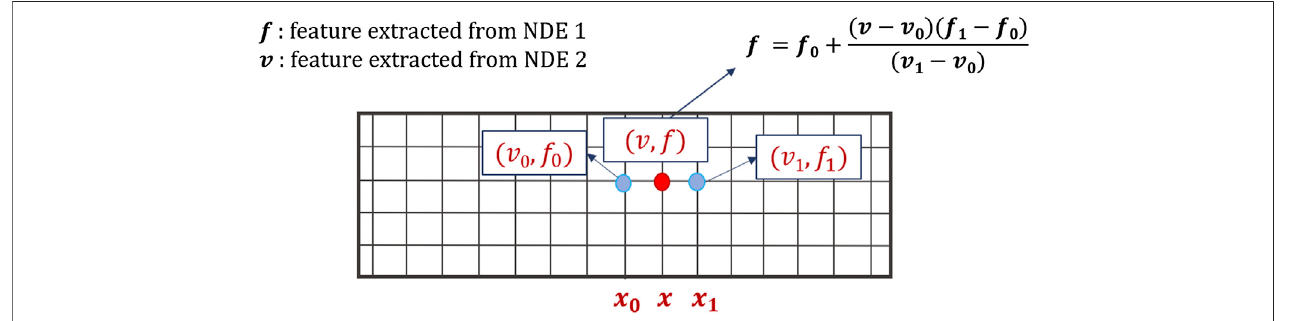
FIGURE 5 | Linear interpolation of NDE